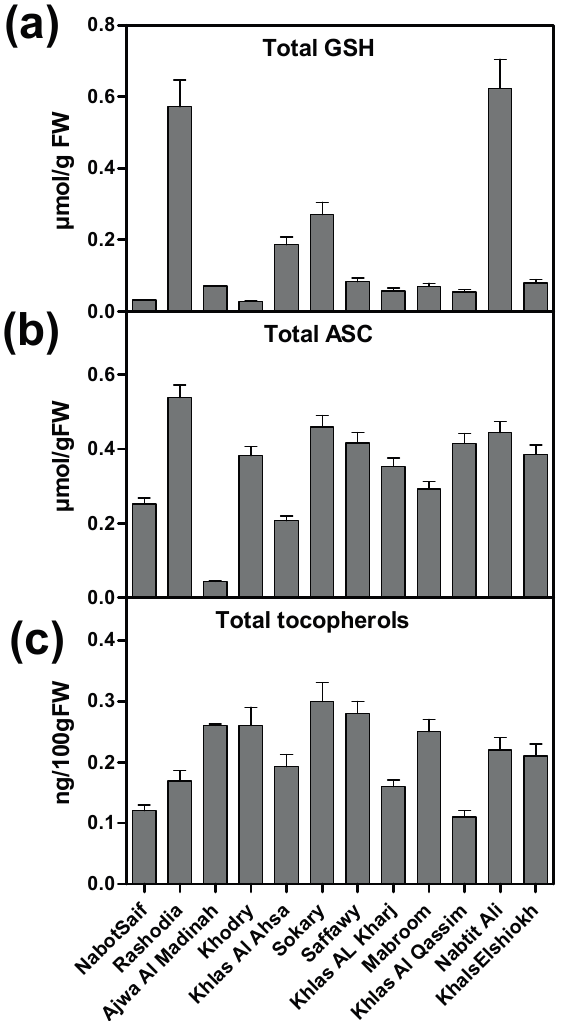
Figure 1. Antioxidant metabolites content: ( a ) Total glutathione (GSH); ( b ) total ascorbate (ASC); ( c ) total tocopherols of 12 Saudi date